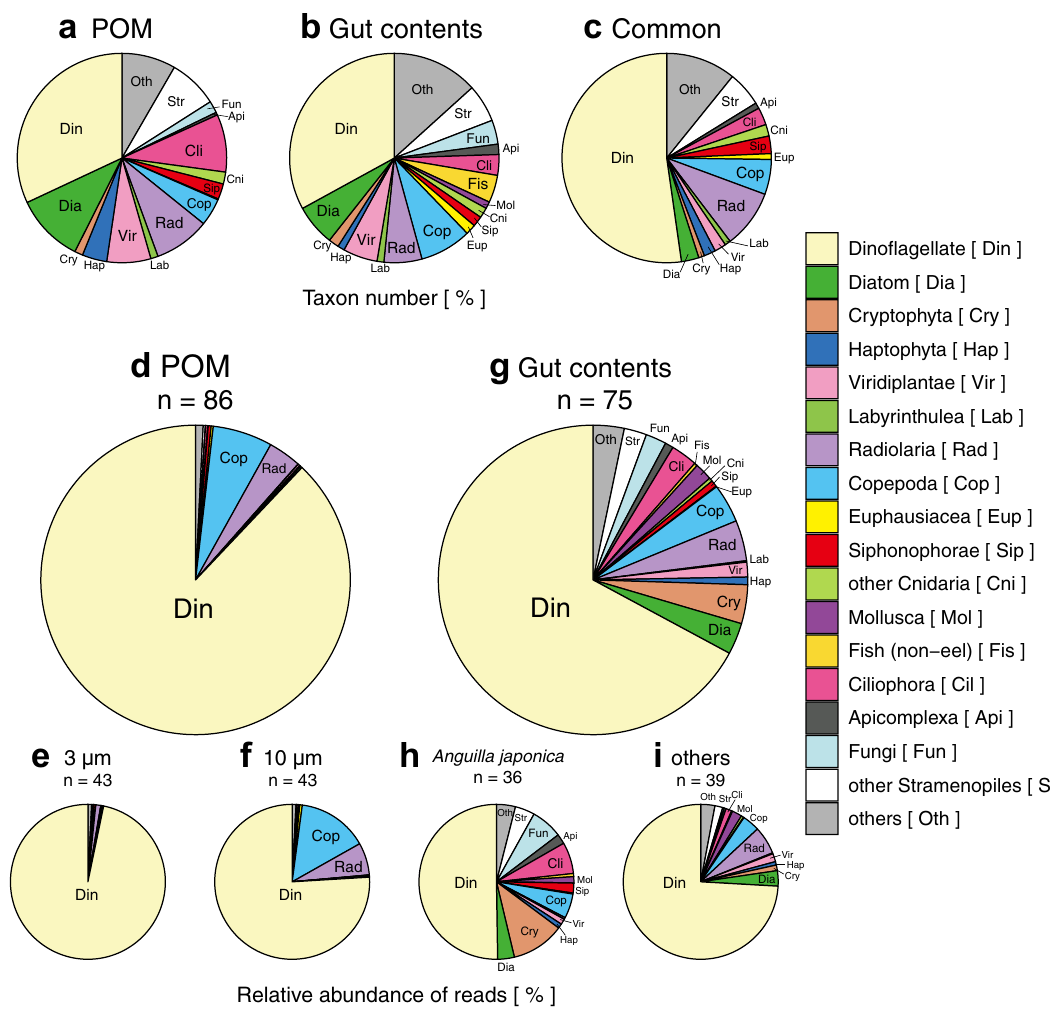
Figure 4. Eukaryotic composition of larval eel gut contents and POM of seawater. Overview of the number of eukaryotic taxa in POM (particulate organic matter) of 86 samples ( a ), eel larva gut contents ( b ), and common taxon number between POM and gut contents ( c ). A complete overview of the eukaryotic composition in 86 POM samples ( d ) and eel larva gut contents of 75 samples ( g ). Complete overview of the eukaryote composition in two size-filtered fractions of POM ( e : 3–10 μm; f : > 10 μm; 43 samples each) and eel larva gut contents of 36 Japanese eel samples ( h ) and the other 39 anguillid eel larva samples ( i